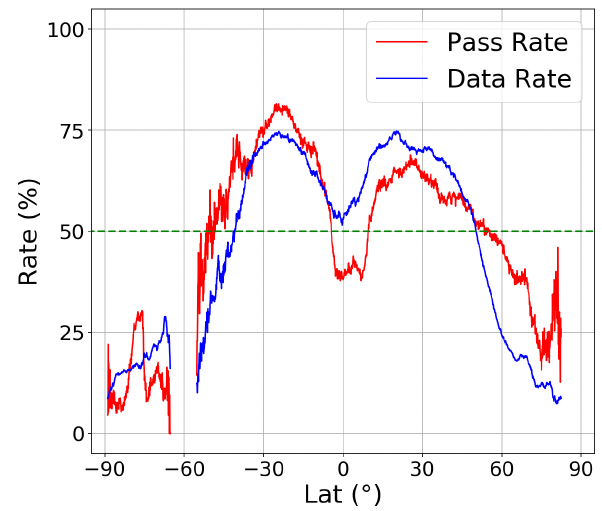
Figure 16. Mean yearly ETAL data rate and ETAL versus MODIS pass rate averaged per latitude (after filtering with the preprocessing). Any latitude that did not have a minimum number of 10 pass rate values was